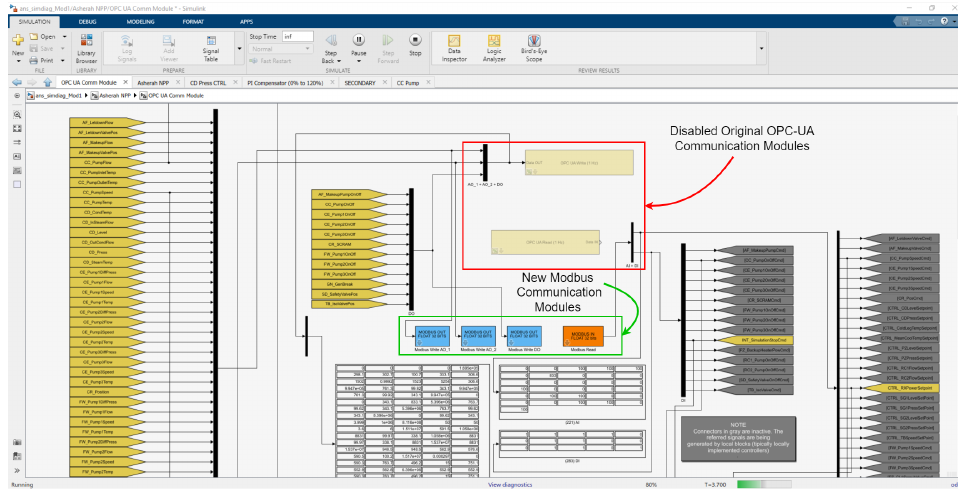
Figure 7. ANS Modbus communications